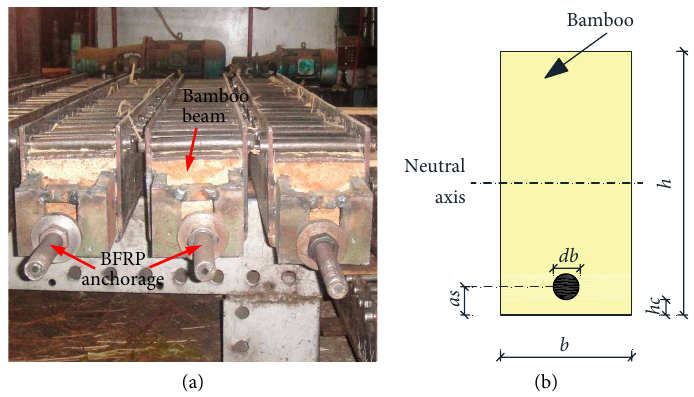
Figure 3: Sketch of completed specimens: (a) photo and (b) cross-section